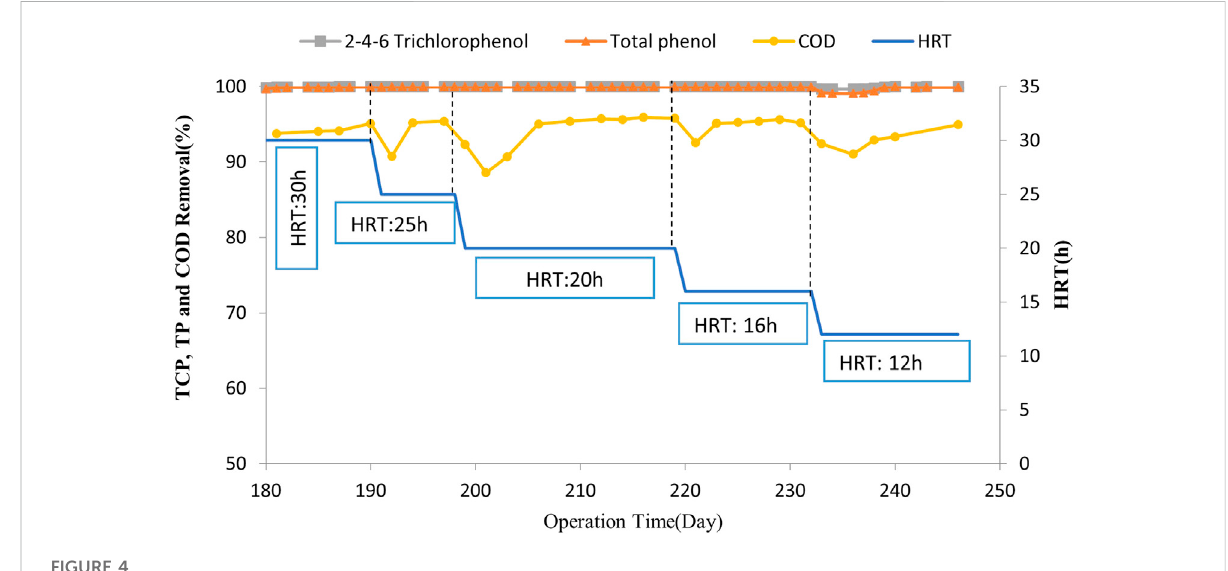
FIGURE 4 The HRT effect on the bioreactor.